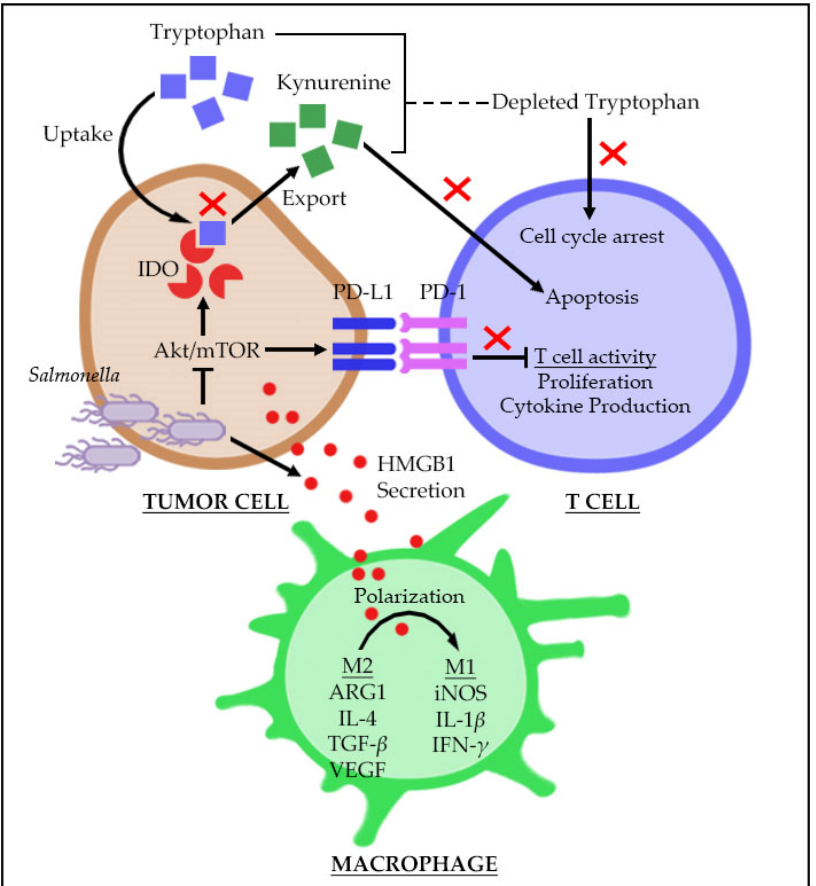
Figure 1. An overview of Salmonella -mediated modulation of tumor-specific immune responses in the tumor microenvironment. Salmonella overcomes the immunosuppressive TME by downregulating tumor-intrinsic IDO and PD-L1, leading to the reactivation and increase in the population of effector T cells. Further, Salmonella directs reprogramming of macrophages toward an antitumor phenotype upon stimulation by extracellular HMGB1. The symbol “X” shown in red means prevention/inhibition of the activity.